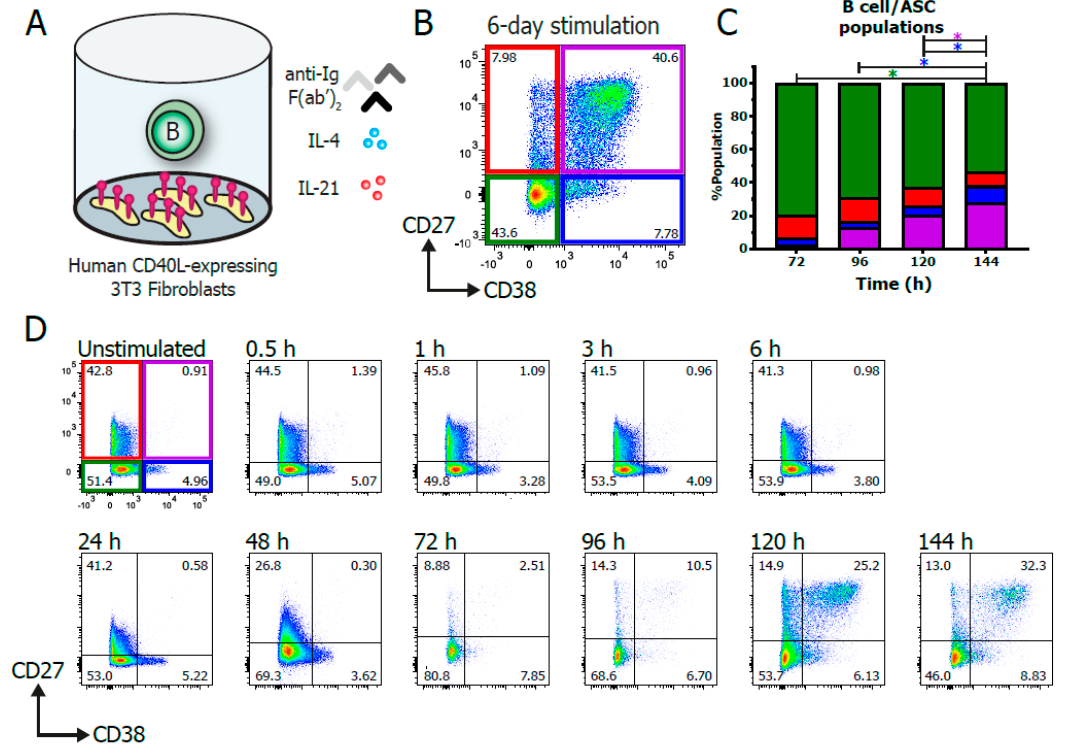
Figure 1. Efficient in vitro generation of human B cell and antibody-secreting cell subpopulations. Total human B cells ( n = 3) were stimulated in vitro to generate multiple B cell and antibody-secreting cell (ASC) subpopulations. ( A ) Schematic overview of the culture system used to induce B cell differentiation. A total of 5000 CD19 + human B cells were stimulated with a human-CD40L-expressing 3T3 feeder layer; an anti-Ig F(ab) 2 mix (5 µ g / mL) targeting IgM, IgG and IgA; and recombinant IL-4 (25 ng / mL) and IL-21 (50 ng / mL) cytokines. ( B ) Representative FACS plot after 6 days of culture based on expression of CD27 and CD38. ( C ) Quantification of the relative percentages of CD27 and CD38 subpopulations in the total CD19 + B cell population between 3 and 6 days of culture. n = 4; p values were calculated by 2-way ANOVA with Tukey’s multiple-comparison test; * p < 0.05. ( D ) Representative FACS plots of a time-course experiment of B cell differentiation dynamics of one B cell donor, as measured over the course of 6 days of culture.